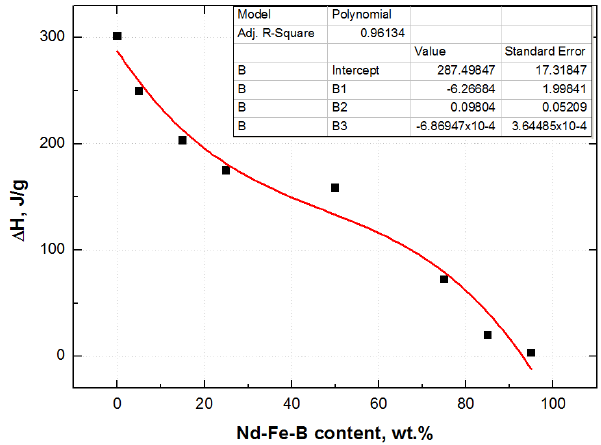
Figure 6. The function of the change of enthalpy with the weight fraction of